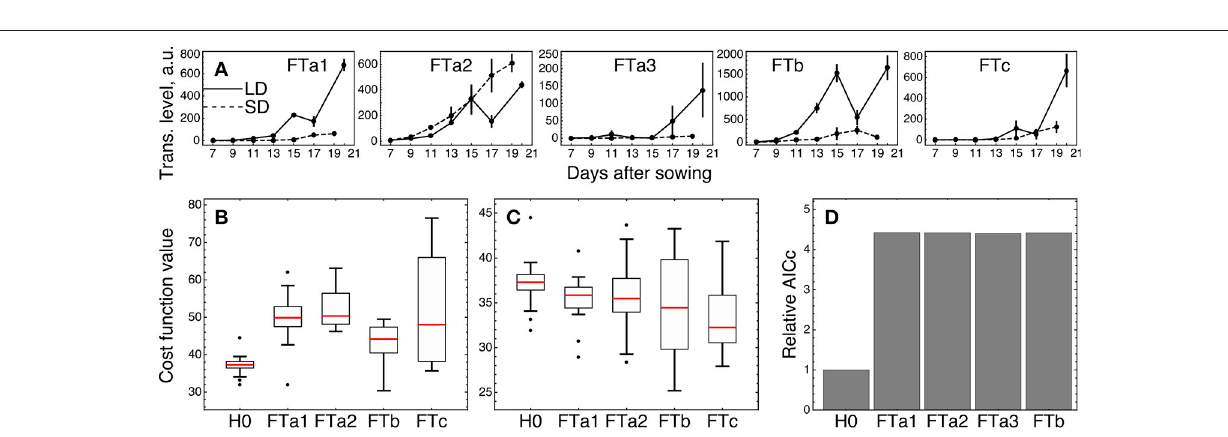
FIGURE 6 | Testing alternative hypotheses on regulation by the FT genes in ICCV 96029. (A) Expression data of the FT genes in ICCV 96029 under SD and LD; reproduced from ( Ridge et al., 2017). (B) Values of the cost function (weighted residual sum of squares; equation (9) in Materials and Methods) quantifying the goodness of fit for model H0 and four versions of model H1 , for all optimized parameter sets. Each version of model H1 is marked on the bottom of the panel by the name of the FT gene participating as a sole FT activator in the model. (C) The same as in (B) , but for model H2 . Each version of model H2 is marked on the bottom of the panel by the name of the FT gene singled out in the model equations from the other FT genes. (D) Akaike information criterion corrected for small data samples (AICc; equation (10) in Material and Methods) for H0 and four versions of model H2 , marked as in (C) . The relative values of AICc normalized to the H0 value are shown. The use of a more conventional form of AICc yields a similar figure ( Supplementary Figure 8 and Supplementary Text